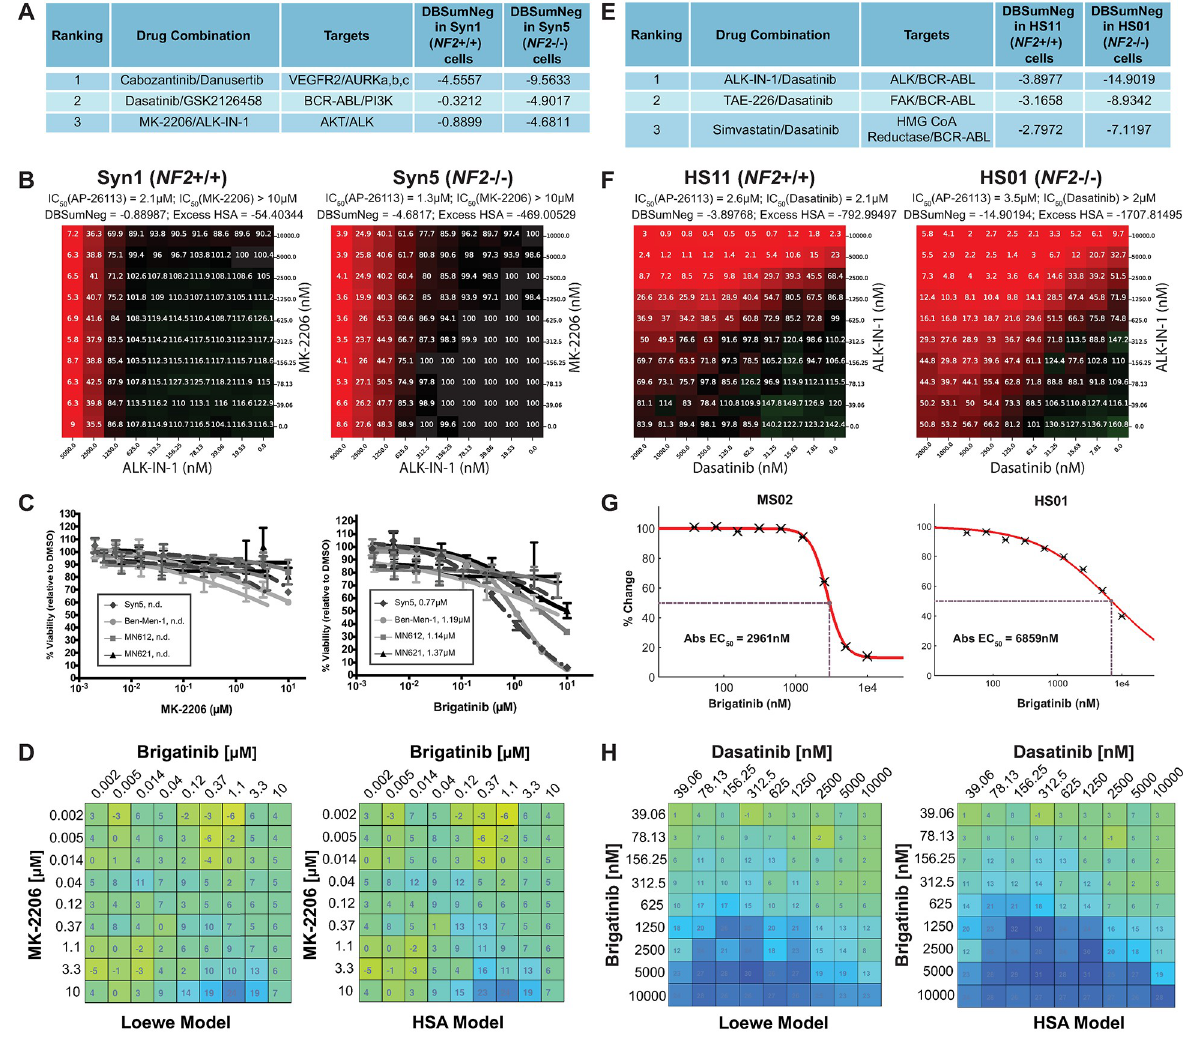
Fig 2. Like ALK-IN-1, brigatinib exhibited growth-inhibitory synergy with MK-2206 or dasatinib in meningioma and schwannoma cells. (A) The top synergistic drug combinations identified for NF2 -deficient meningioma cells. (B) 10x10 dose-viability response matrix of ALK-IN-1 vs MK-2206 in Syn1 and Syn5 cells, assessed at 72h. (C) Single-drug dose-response curves (DRCs) for MK-2206 (left) or brigatinib (27) were generated for human NF2 -null cell lines, including Syn5, Ben-Men-1, and two primary meningiomas (MN612, MN621). Drug concentrations are outlined under Supplementary Methods in S1 File. n.d., not determined. Data is expressed as +/- SEM. (D) Combination treatment of Ben-Men-1 cells was carried out in a 10x10 dose-matrix format using the same increasing concentration range of MK-2206 and brigatinib as with single DRCs. Heatmaps were generated on a colorimetric scale using Combenefit software, which calculates the drug interaction effects (relative to vehicle/ DMSO control). (E) The top synergistic drug combinations identified for NF2-related schwannoma cells. (F) 10x10 dose-viability response matrix of ALK-IN-1 vs dasatinib in HS11 and HS01 cells, assessed at 72h. (G) Brigatinib dose-response in mouse MS02 and human HS01 cells at 60 and 72h, respectively. (H) Loewe and highest single agent (HSA) synergy matrix analysis of brigatinib vs. dasatinib in HS01 cells treated for 72h.